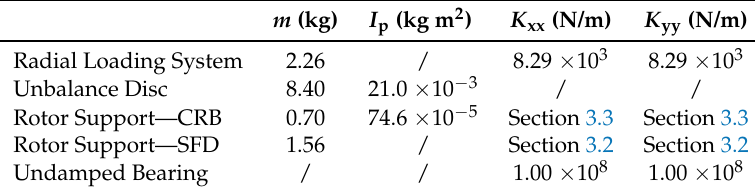
Figure 2. Discretized model for rotor dynamic numerical study. Table 1. Additional mass, polar inertia and stiffness properties